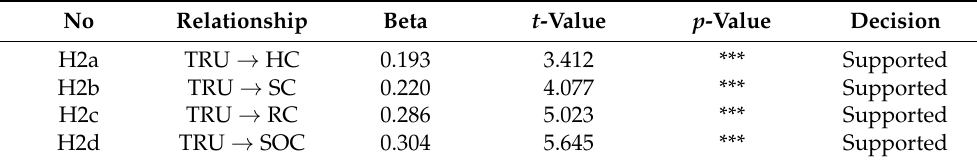
Table 6. Relationship between trust and intellectual capital. No Relationship Beta t -Value p -Value